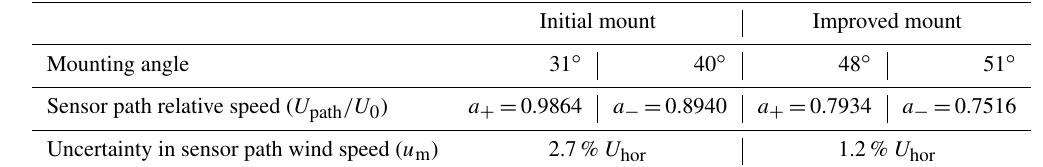
Table 3. Mounting angles, sensor path wind speed and uncertainty due to mounting accuracy.